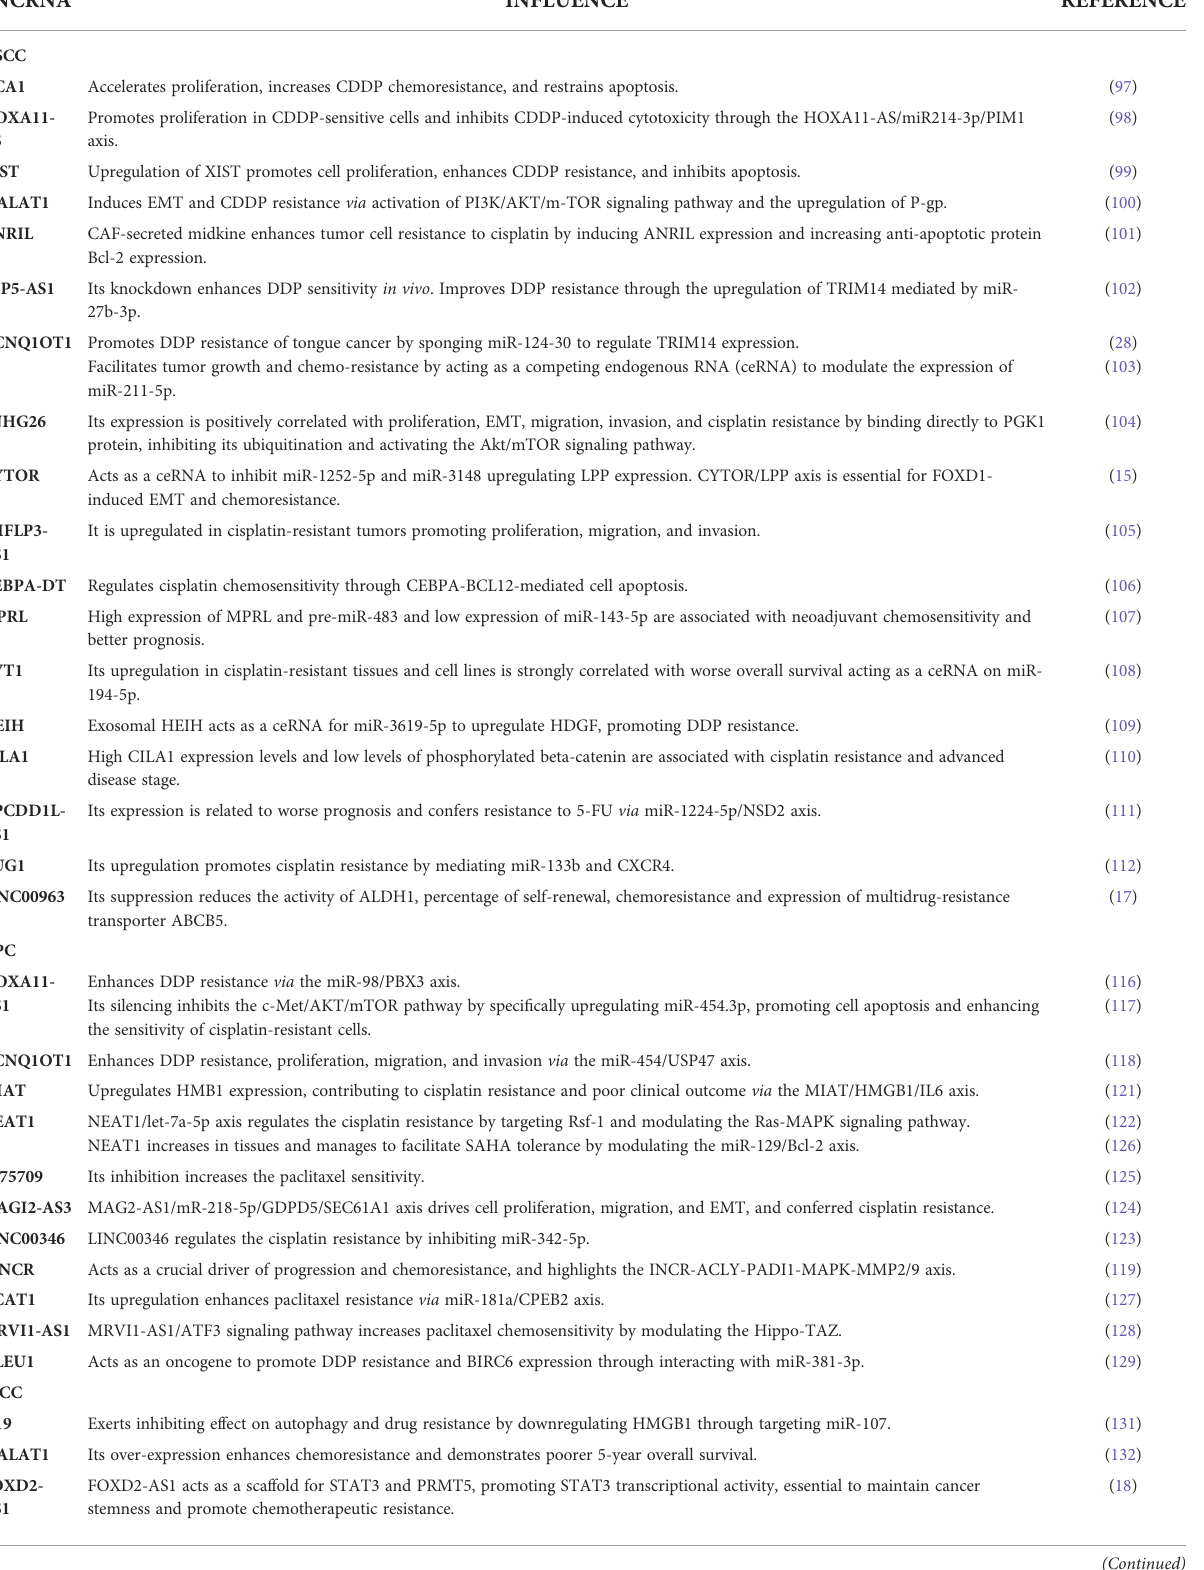
TABLE 2 LncRNAs and their in fl uence on HNSCC drug resistance. LNCRNA